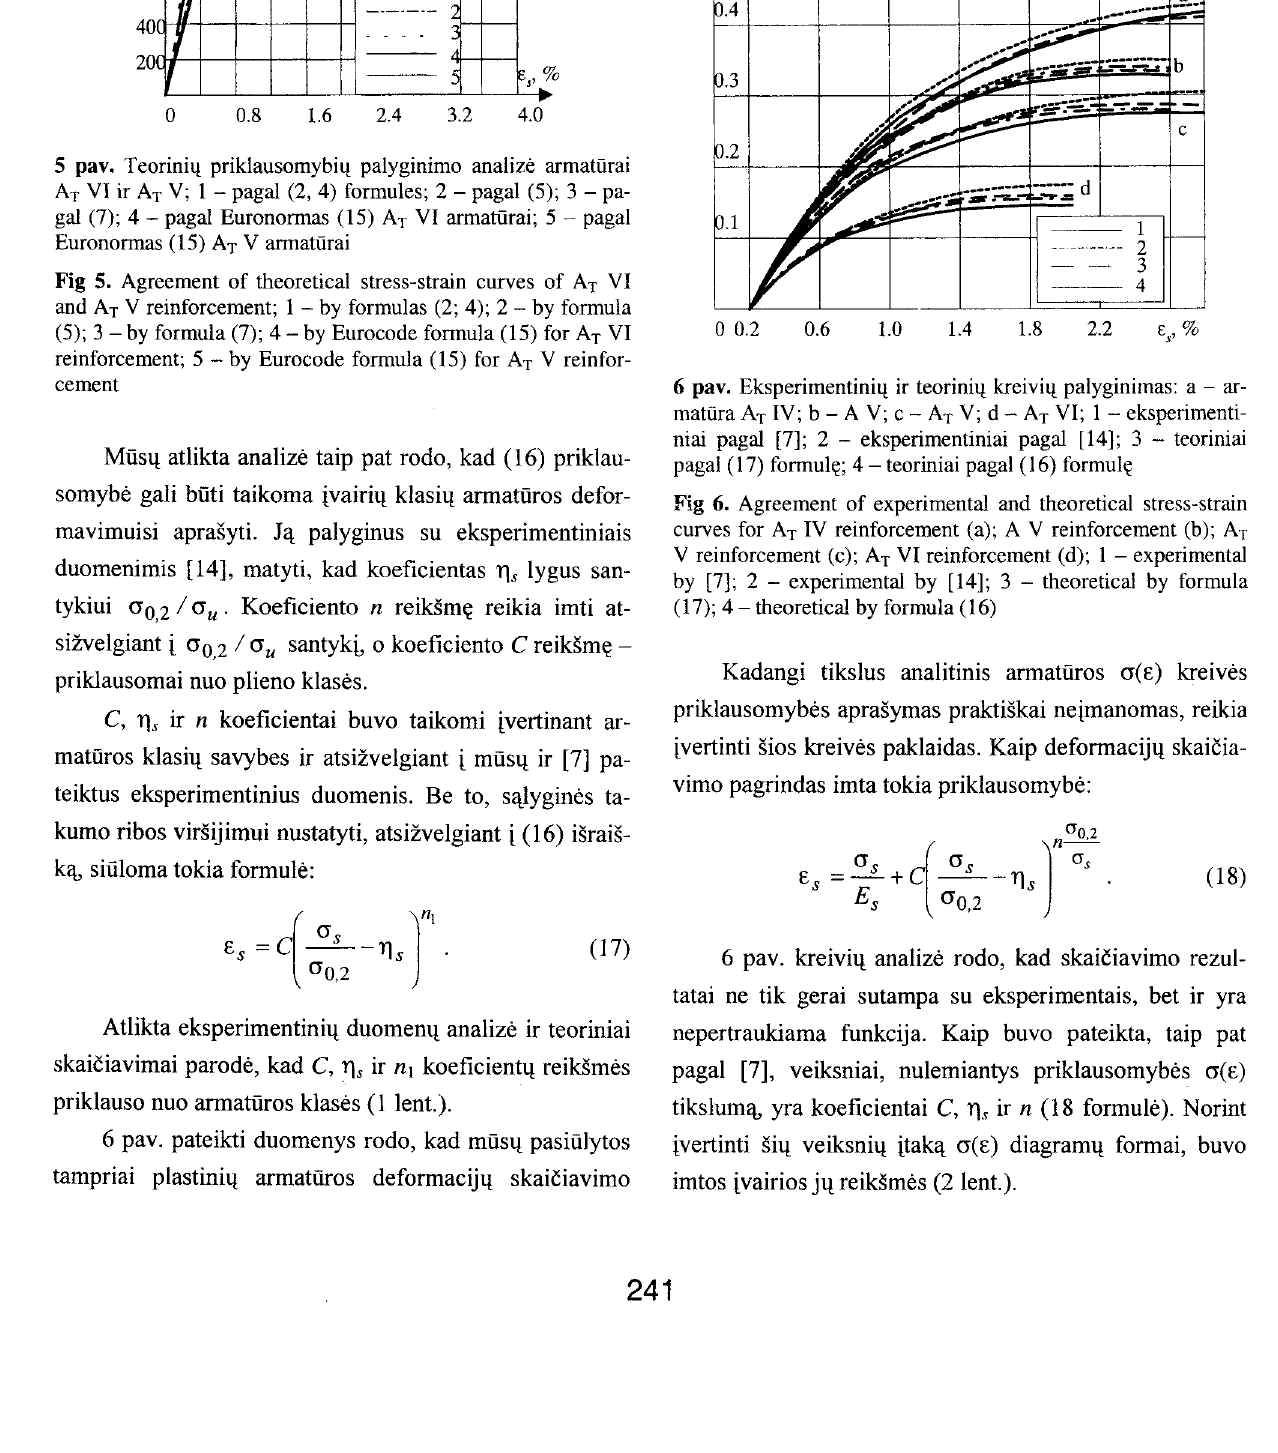
Table 1. Coefficients C, Y], and n Armatliros